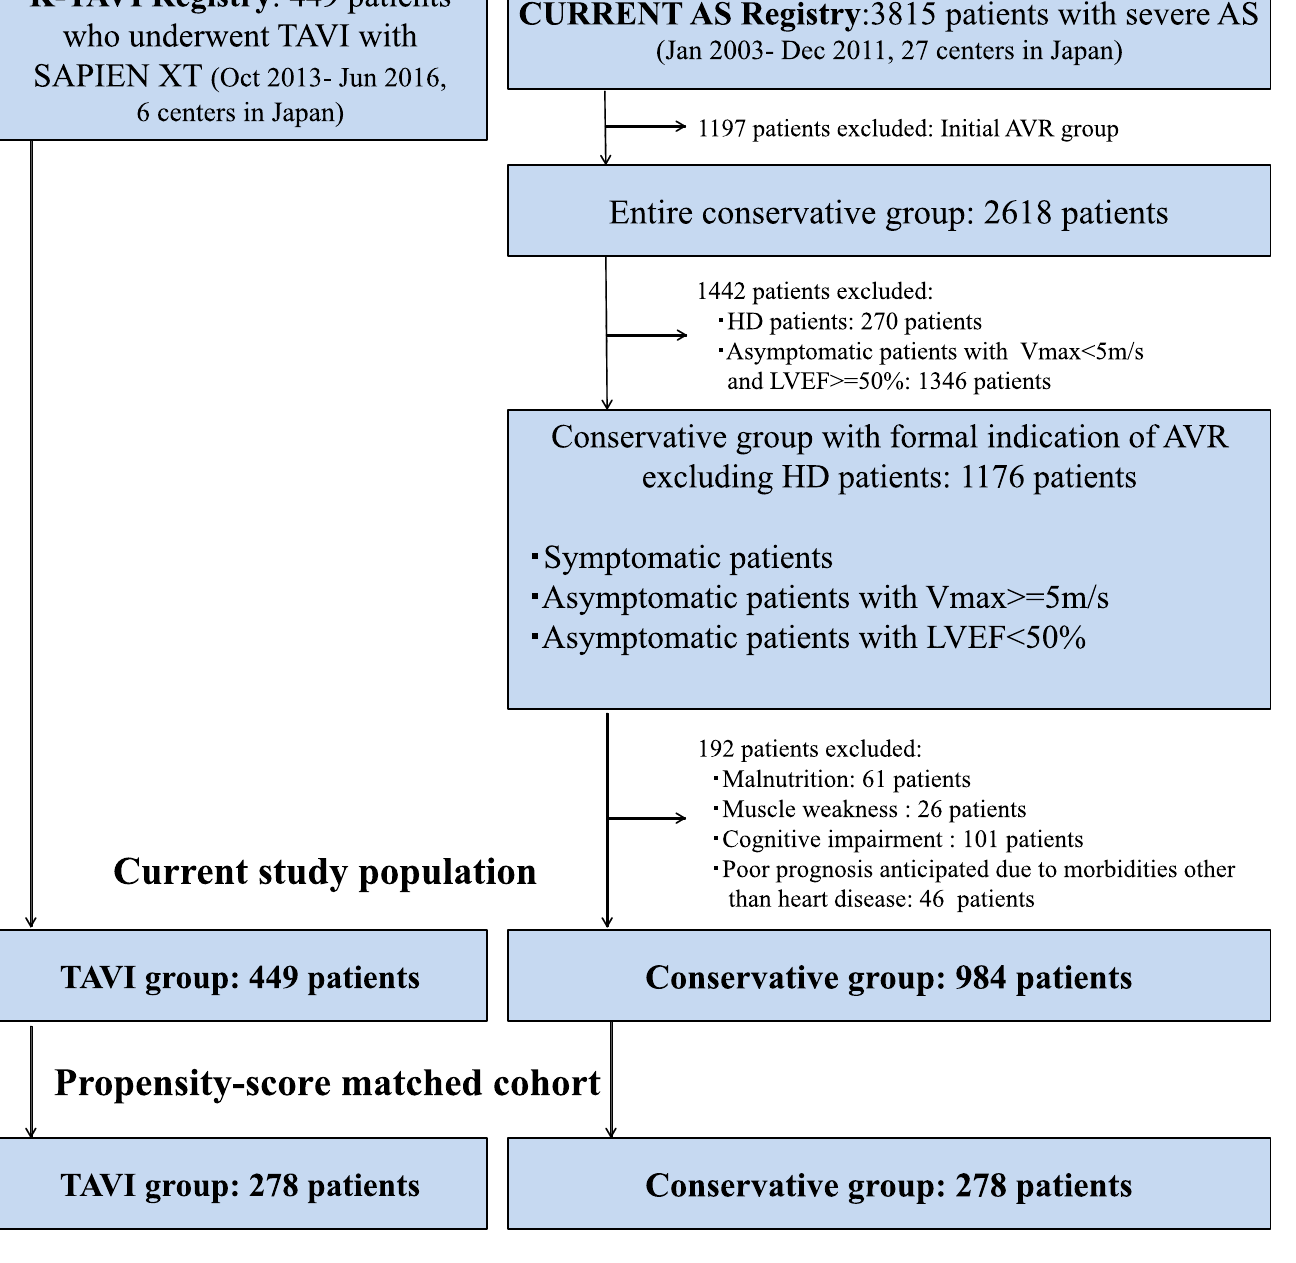
Fig 1. Study flowchart. CURRENT AS, Contemporary outcomes after sURgery and medical tREatmeNT in patients with severe Aortic Stenosis; K-TAVI, Kyoto University-related hospital Transcatheter Aortic Valve Implantation; AVR, aortic valve replacement; HD, hemodialysis; Vmax, peak aortic jet velocity; TAVI, transcatheter aortic valve implantation; LVEF, left ventricular ejection fraction.